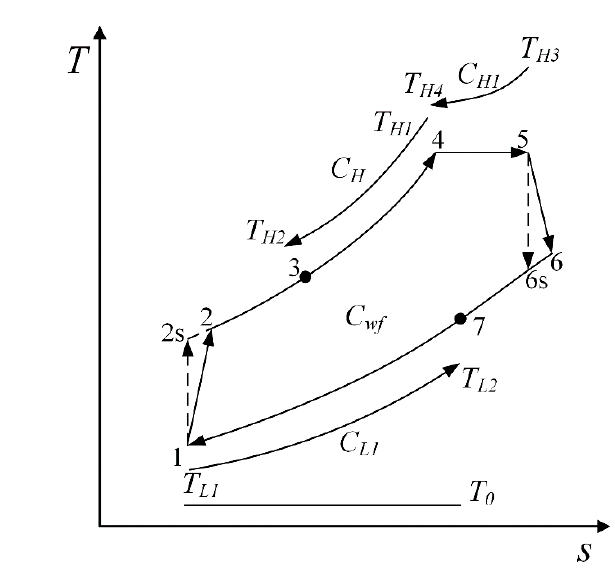
Entropy 2020 , 22 , x